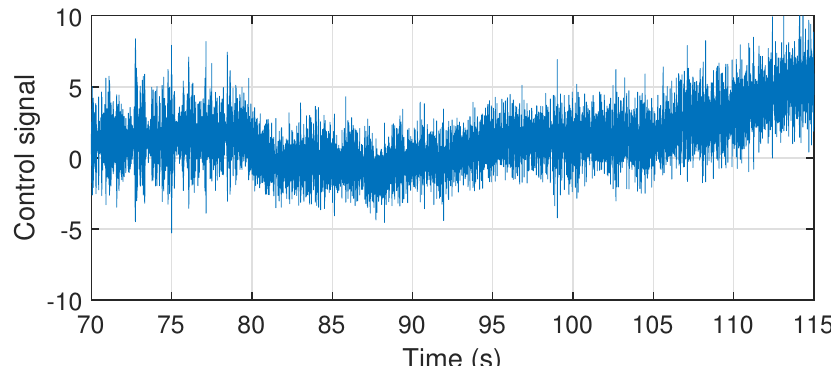
Figure 23. Control signal for roll axis.